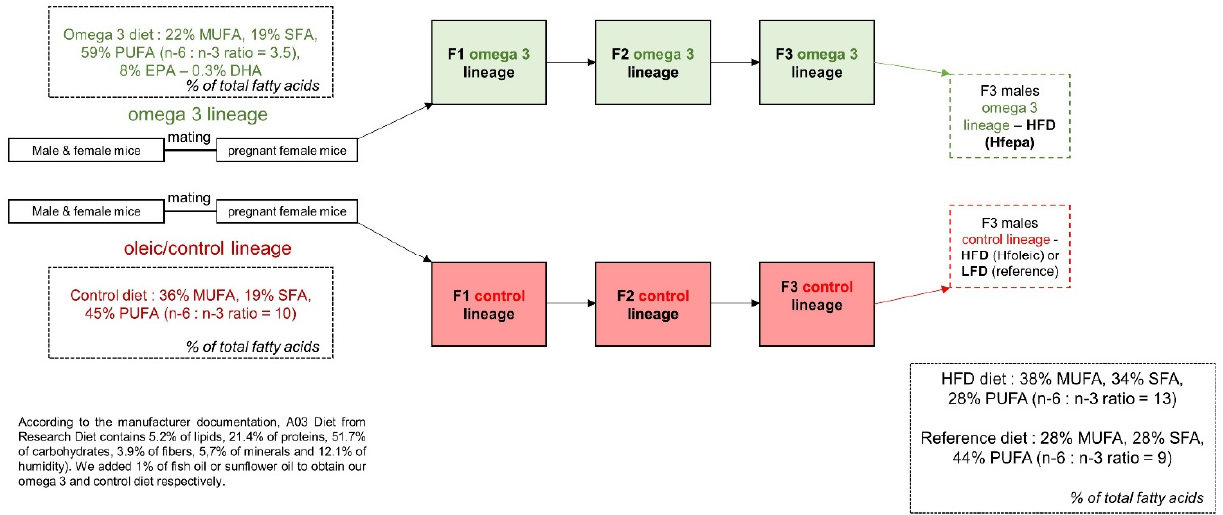
Figure 6. Design of the dietary intervention to obtain F3 animals from an n-3 PUFA and control lineage and explore the effect of a high-fat diet (HFD) in each lineage. MUFA, monounsaturated fatty acids; SFA, saturated fatty acids; PUFA, polyunsaturated fatty acids. HFD, high-fat diet; LFD, control low fat diet.